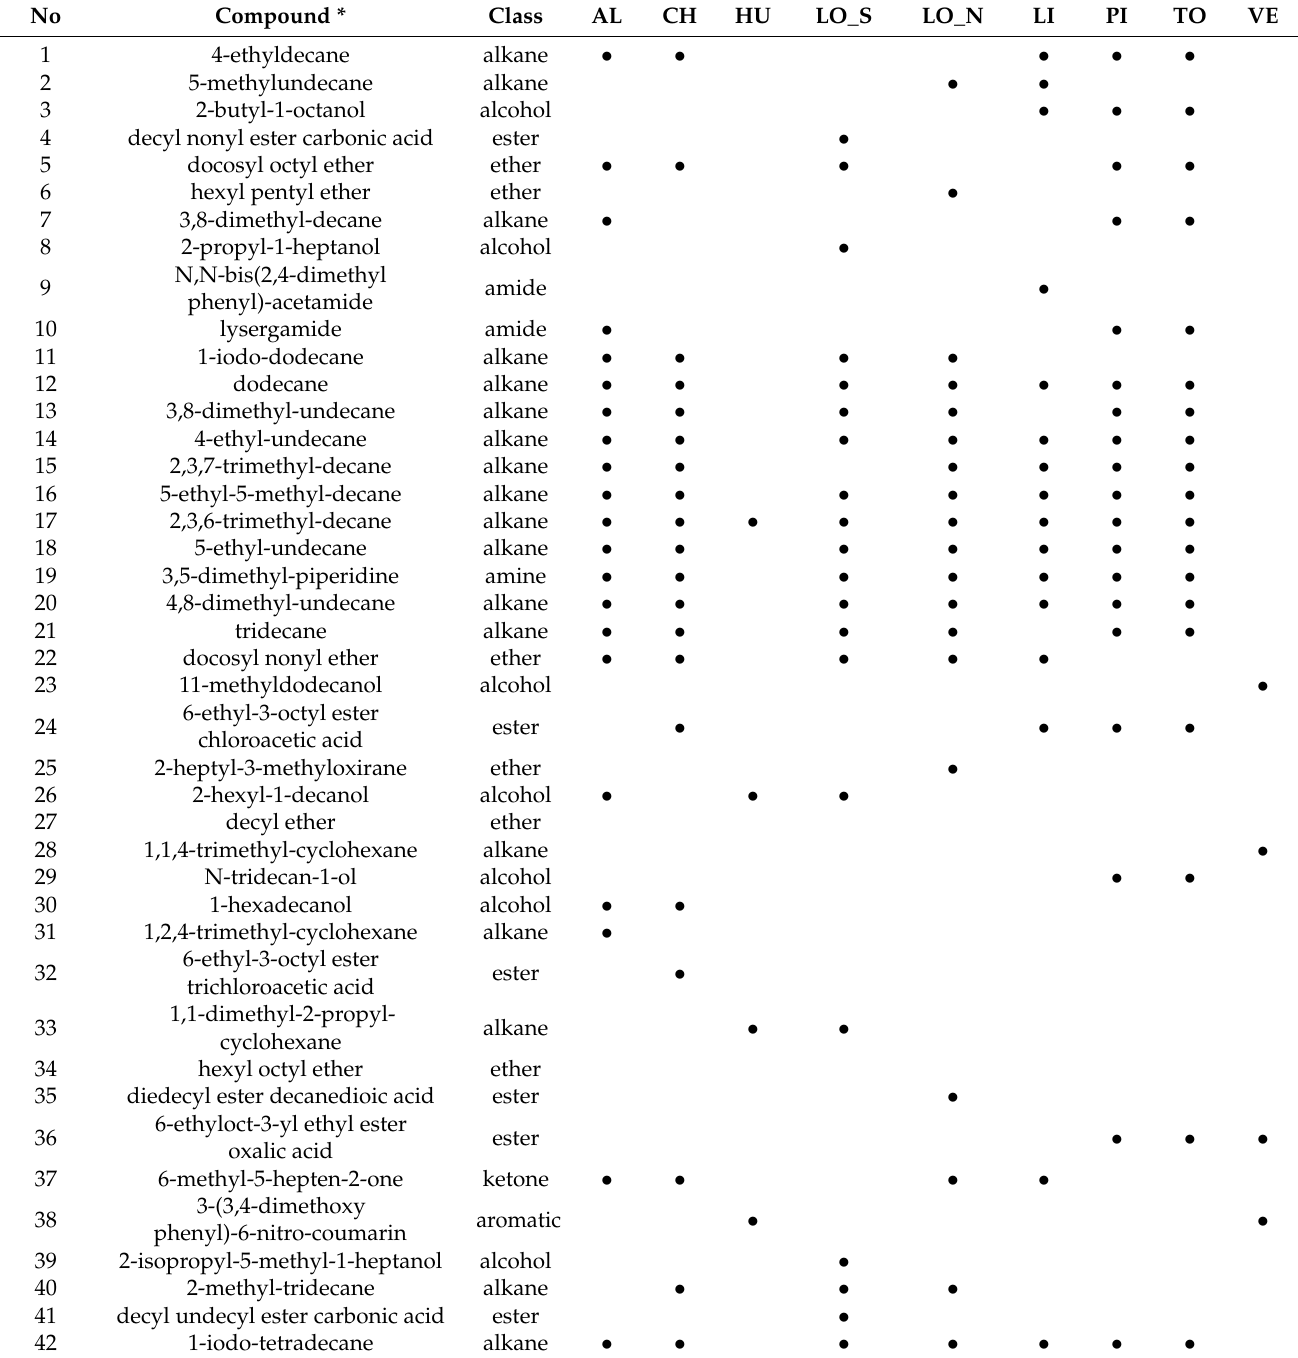
Table A2. Presence of detected volatile compounds in different samples: AL—Albarrac í n; CH— Chelva; HU—Hu é tor; LO_S—Loarre_September; LO_N—Loarre_November; LI—Lierta; PI—Pina de Montalgrao; TO—El Toro; VE—Los V é lez *. Symbol “ • ” means that compound was present in a sample